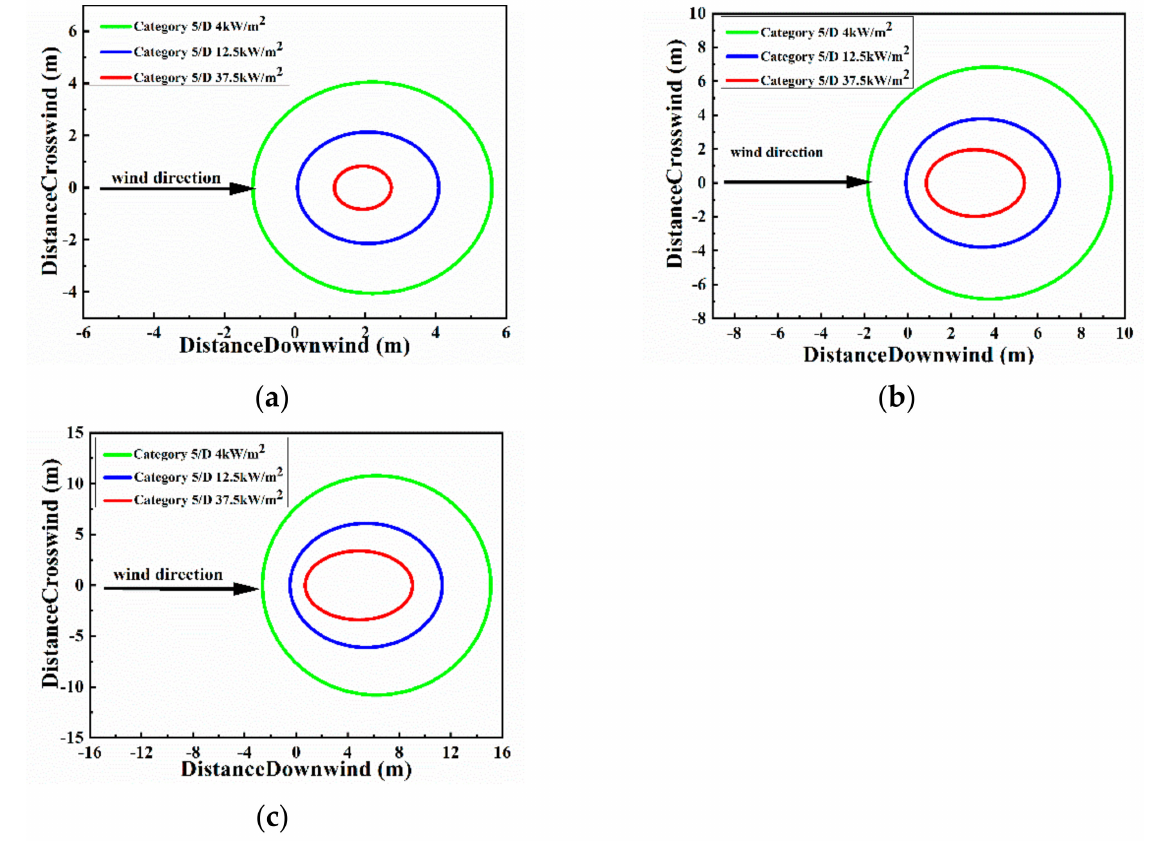
Figure 12. The simulated range of jet fire under different leakage flowrates of ( a ) 9120.4 kg/h, ( b ) 584.8 kg/h, and ( c ) 705.2 kg/h.